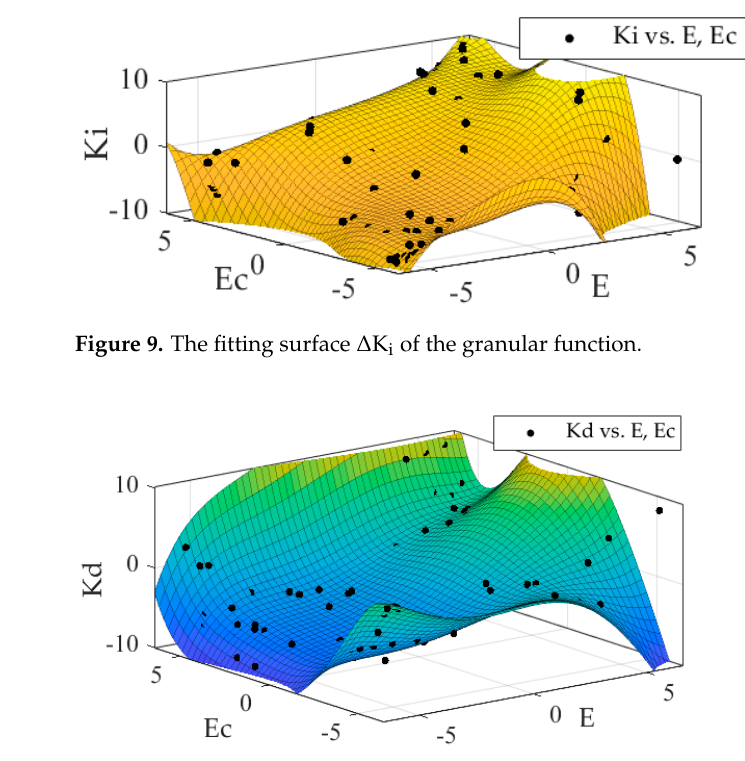
Figure 10. The fitting surface ∆ K d of the granular function. For example: the coefficients of the fifth-order fitting granular function for ∆ K i are shown in Table 5. Table 5. Fifth-order fitting granular function coefficient for ∆ K i Coefficient